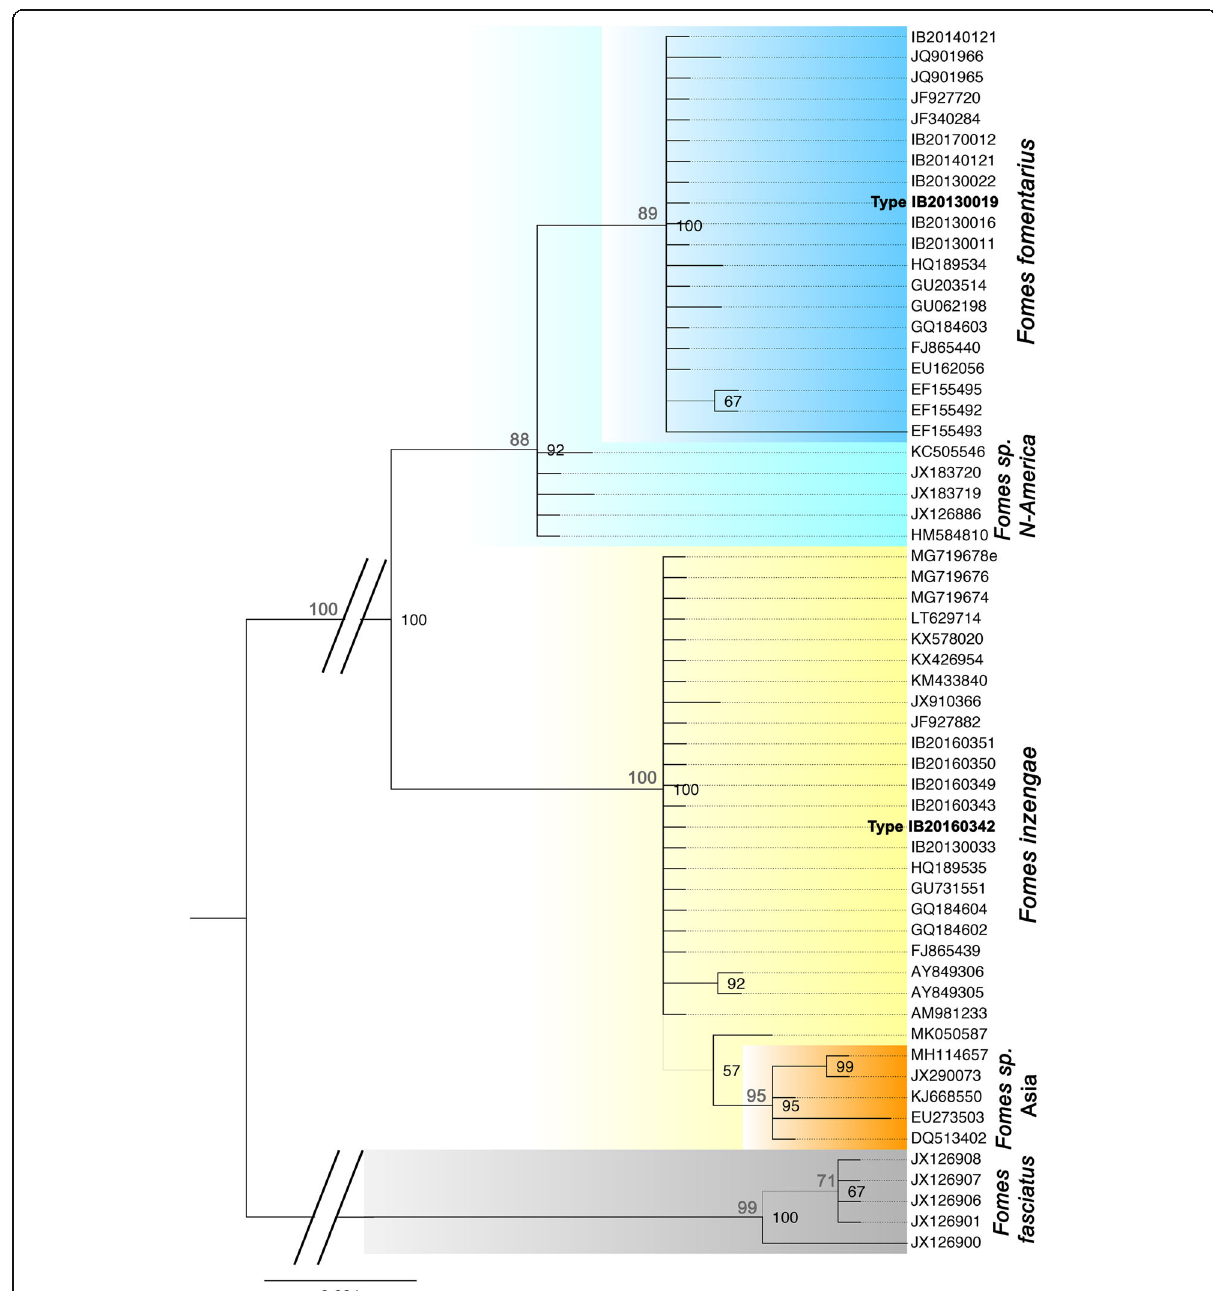
Fig. 1 ITS-based Bayesian phylogeny of Fomes fomentarius s. lat rooted with F. fasciatus . Maximum Parsimony bootstrap values > 70% appear above the branches in grey. Bayesian probabilities > 65% appear in black, right of the respective node. Grey branches in the phylogeny are not supported. Fomes inzengae is strongly supported as a distinct